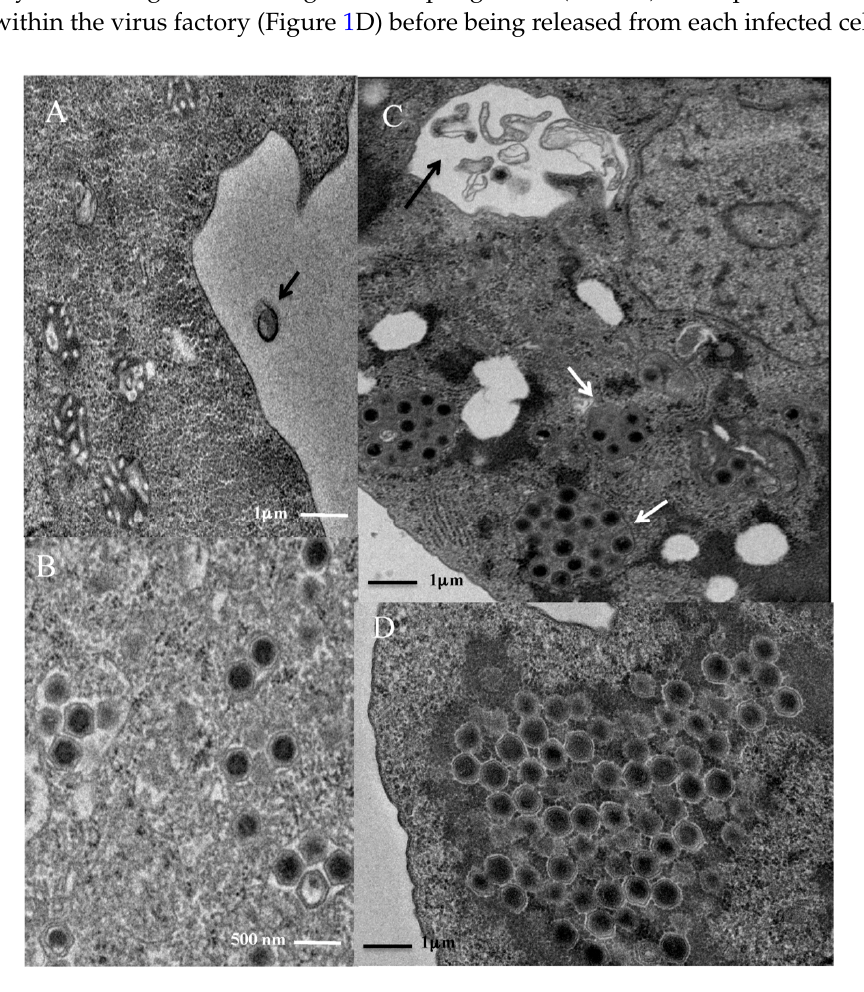
Figure 1. Observation of Kaumoebavirus in Vermamoeba vermiformis at selected times of development. Kaumoebavirus particles (black arrow) are phagocytized ( A ) then observed in the cytoplasm of V. vermiformis mostly packaged in clumps of two to four particles ( B ). After the eclipse phase, new virions may be observed within the virus factory ( C , D ). During the early stage of its formation, the virus factory of Kaumoebavirus is not round-shaped but poly-lobed. During the microtome cut, some slice planes showed newly formed viruses in these lobes as clusters of virions (white arrows). At this stage, remnants of phagocytized particles may be observed (black arrow) ( C ). At a late stage, the virus factory loses its poly ‐ lobed aspect for a large round vacuole aspect and appears completely filled with Kaumoebavirus mature particles ( D ).